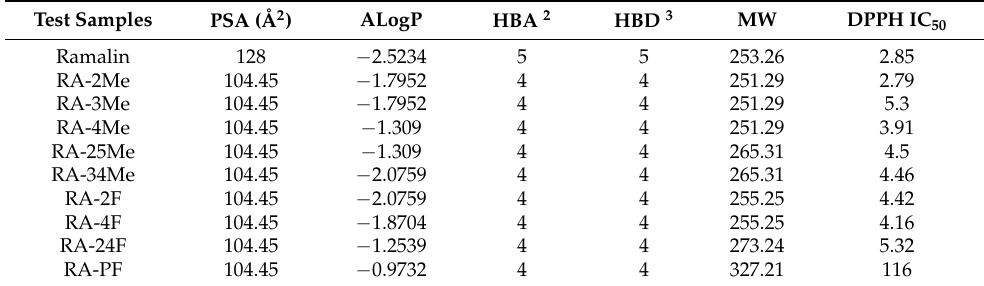
Table 1. Properties of potentially active molecules and DPPH IC 50 ( µ M) 1 values.